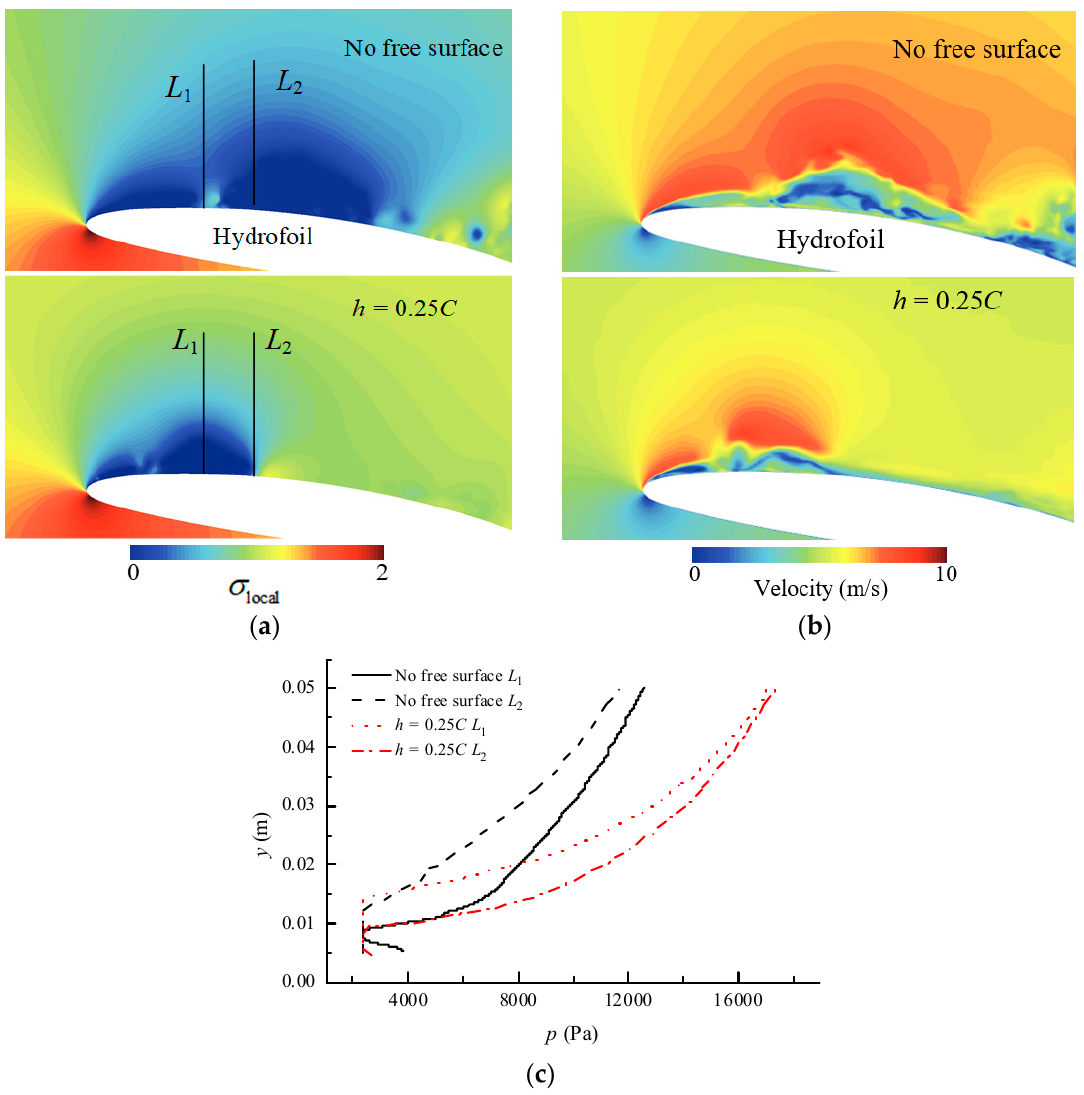
Figure 8. Comparison of the local cavitation number ( a ) and local velocity field ( b ) on the mid-section plane without free surface and with the free surface, ( c ) vertical pressure distribution in hydrofoil cavitation region.